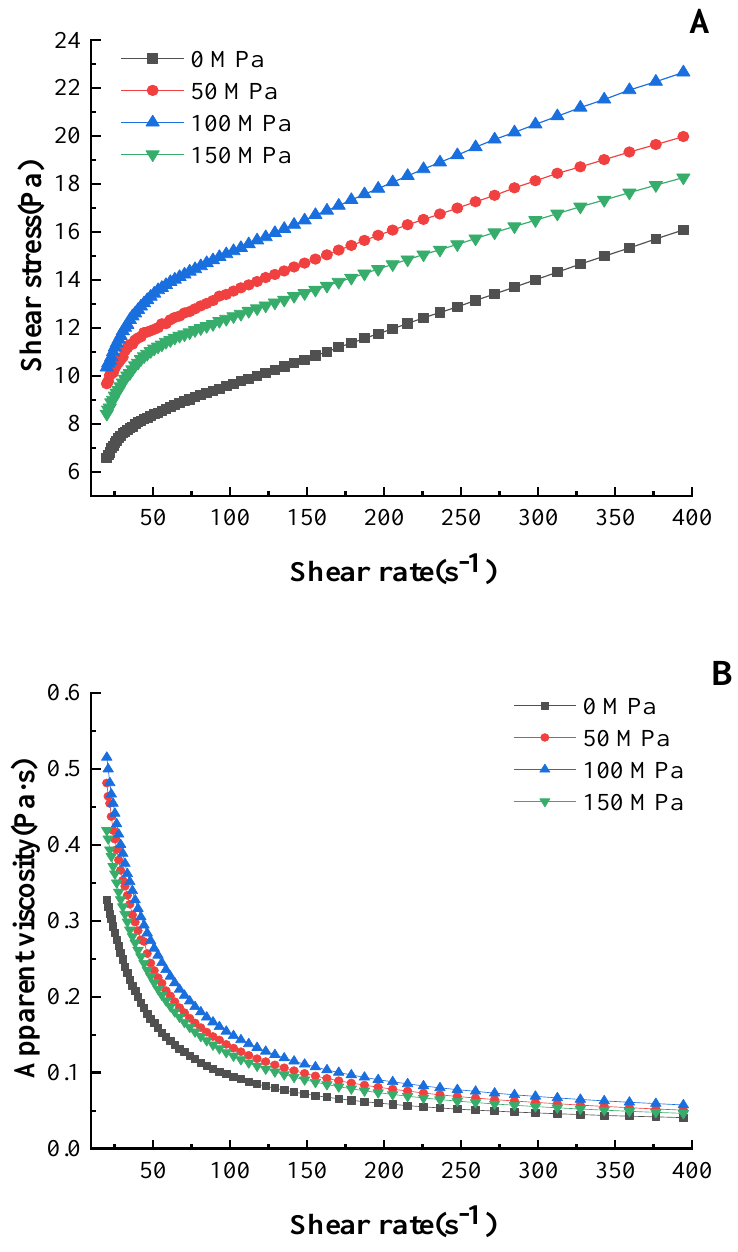
Figure 1. The shear stress (Pa) and apparent viscosity (Pa • s) of pork myofibrillar protein with high-pressure homogenization-modified soy 11S globulin. ( A ): shear stress (Pa); ( B ): apparent viscosity (Pa • s).